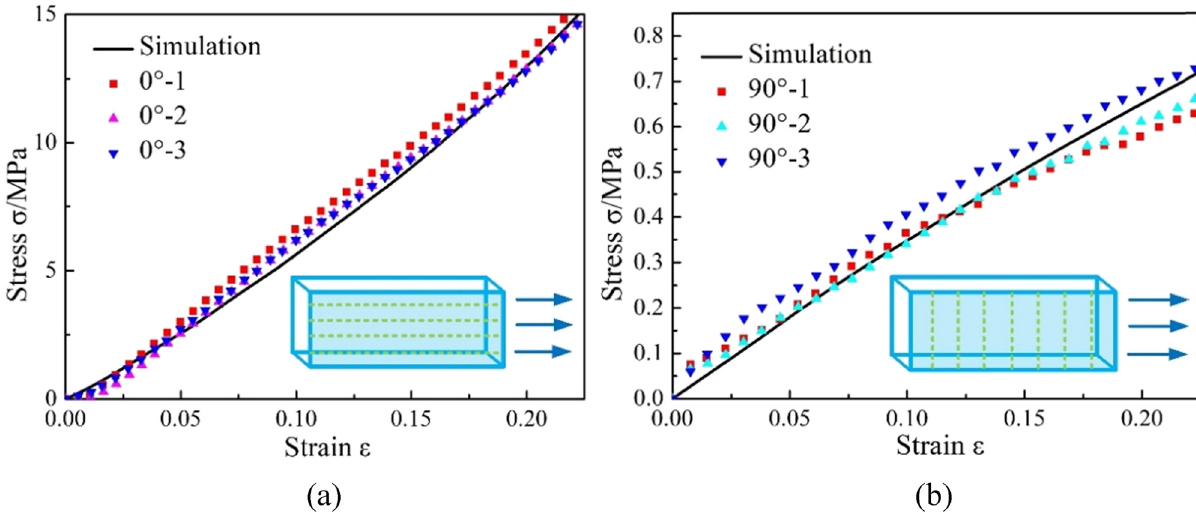
Figure 8: Uniaxial tension of cord – rubber composite: ( a ) stress – strain curve of vertical tension and ( b ) stress – strain curve of transverse tension.